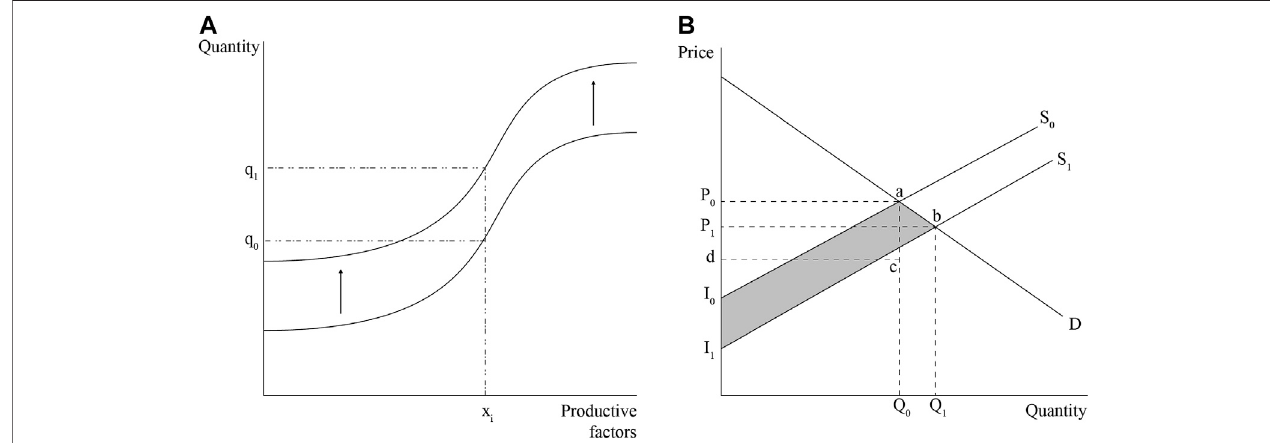
FIGURE 1 | Effects of technological change at different scales: a) Production function (micro level); b) Producer and consumer surplus (macro level). Source: Adapted from Alston et al. (1995,